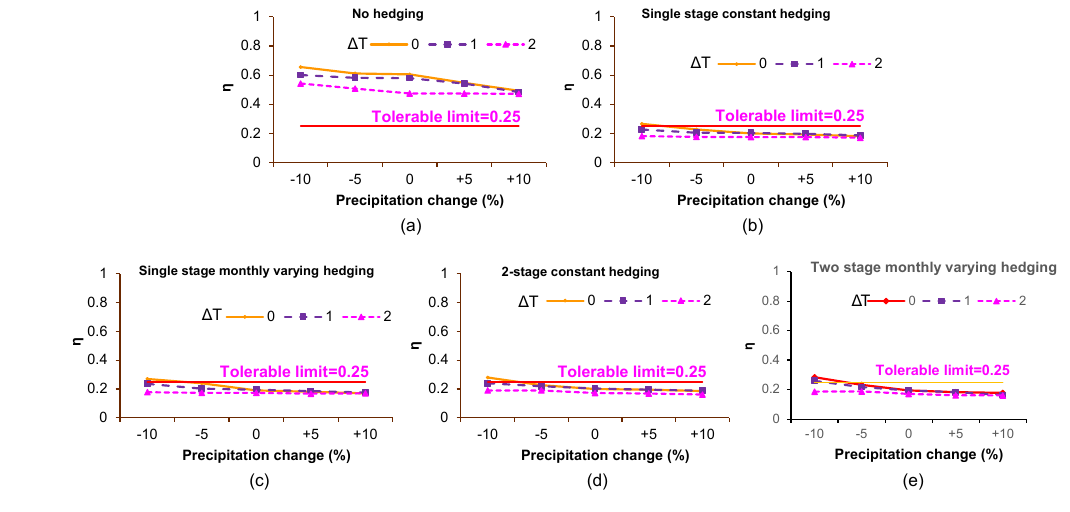
Figure 9. Hedging effect on reservoir performance